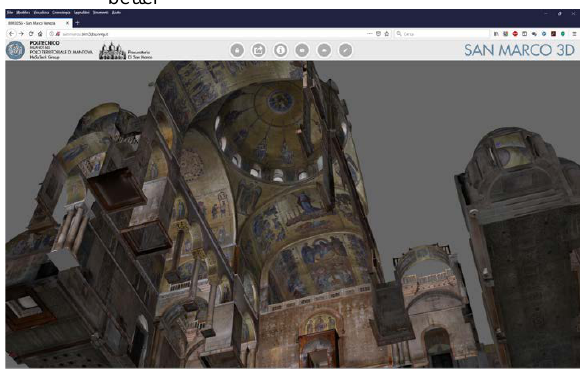
Figure 13: The used part for the test of San Marco in